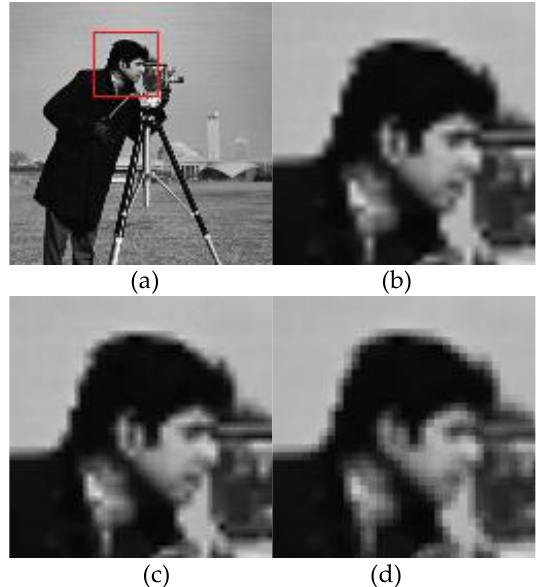
Figure 5. A test image-inside a red square ( a ) interpolated by the TB ( b ), MD ( c ), and HR ( d ).